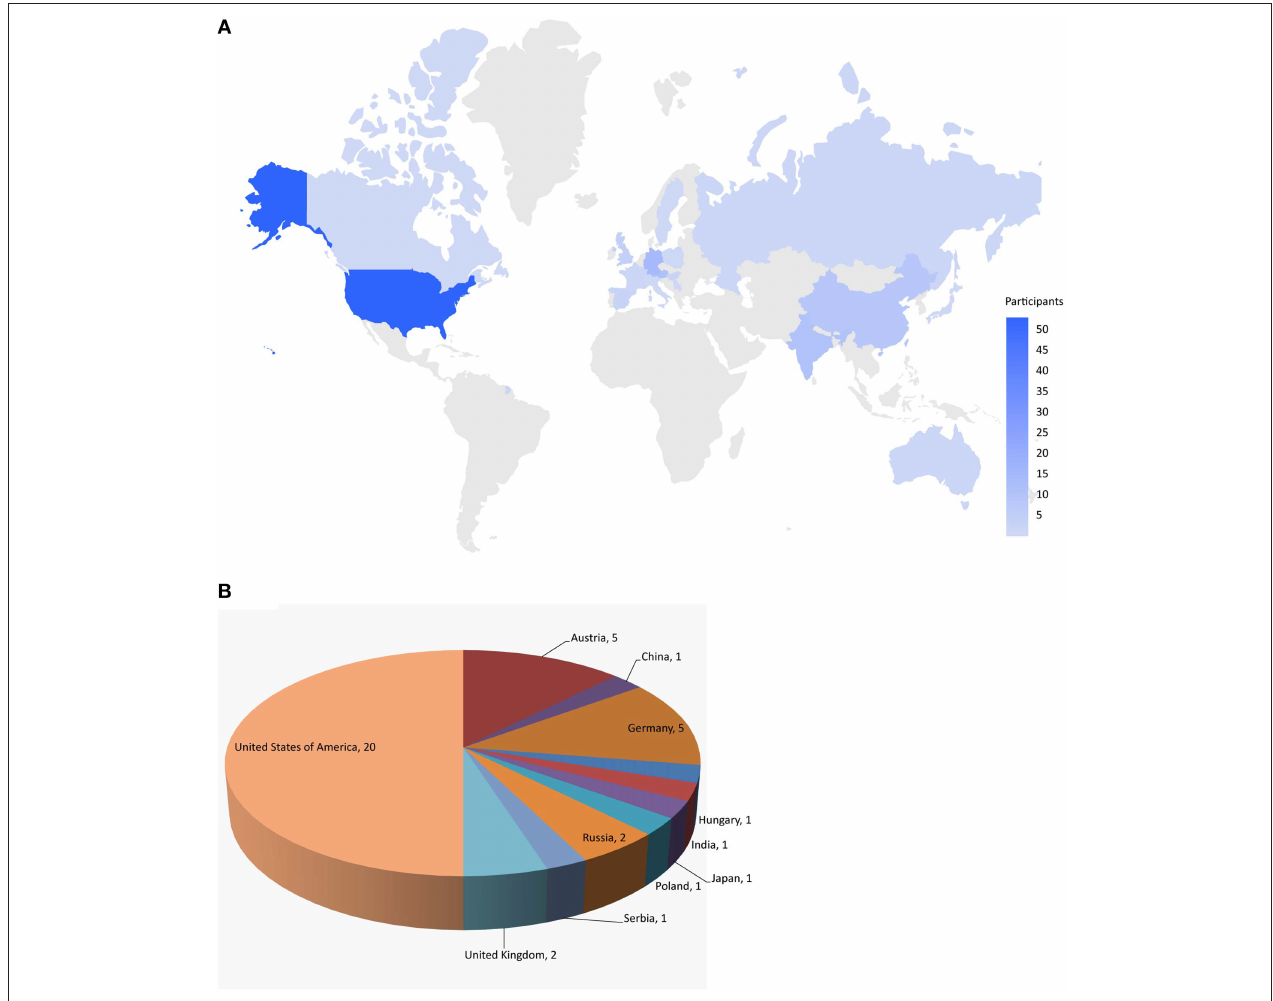
FIGURE 1 | Worldwide challenge participation. (A) Distribution of individuals registered for the challenge. (B) Distribution of teams that submitted models for final